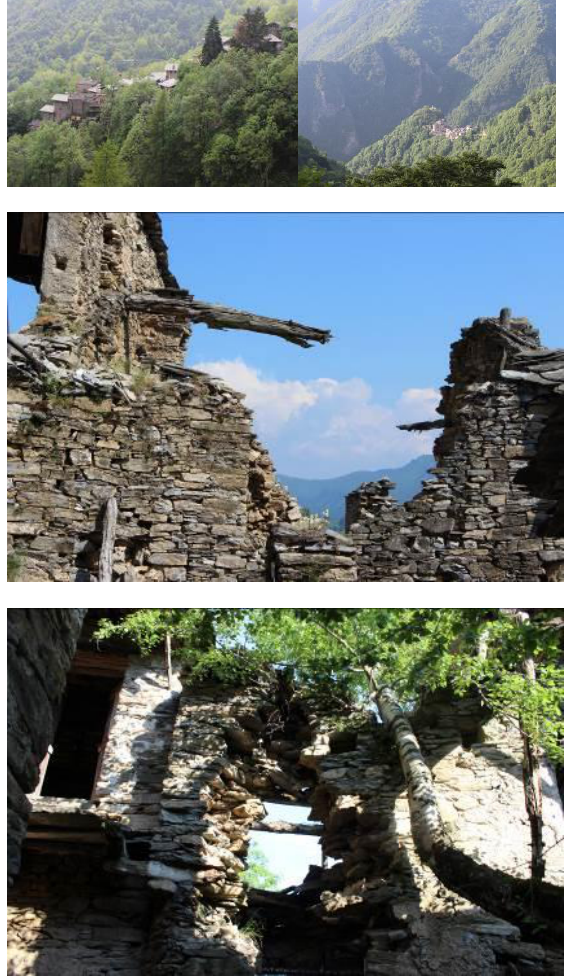
Figure 1 (a,b,c,d,) The steepness of the slopes valleys, the forest that surrounds the villages, the houses in ruins and the natural vegetation that has invaded the home